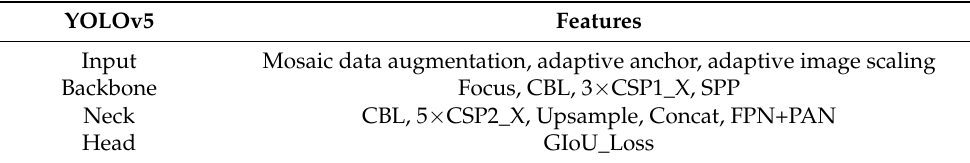
Table 2. YOLOv5 network structure.